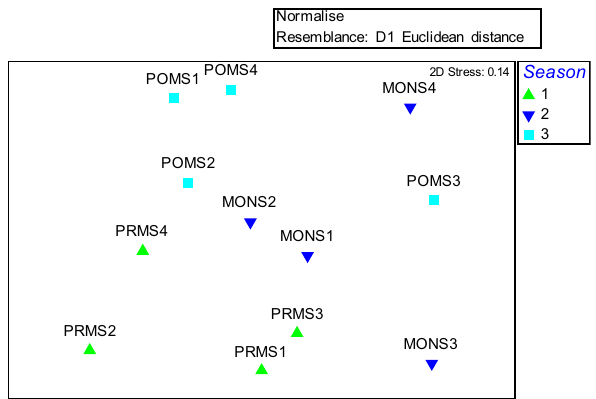
Fig. 3 NMDS showing the environmental variables recorded in vari- ous stations and seasons (1: pre-monsoon; 2: monsoon; 3: post-mon-